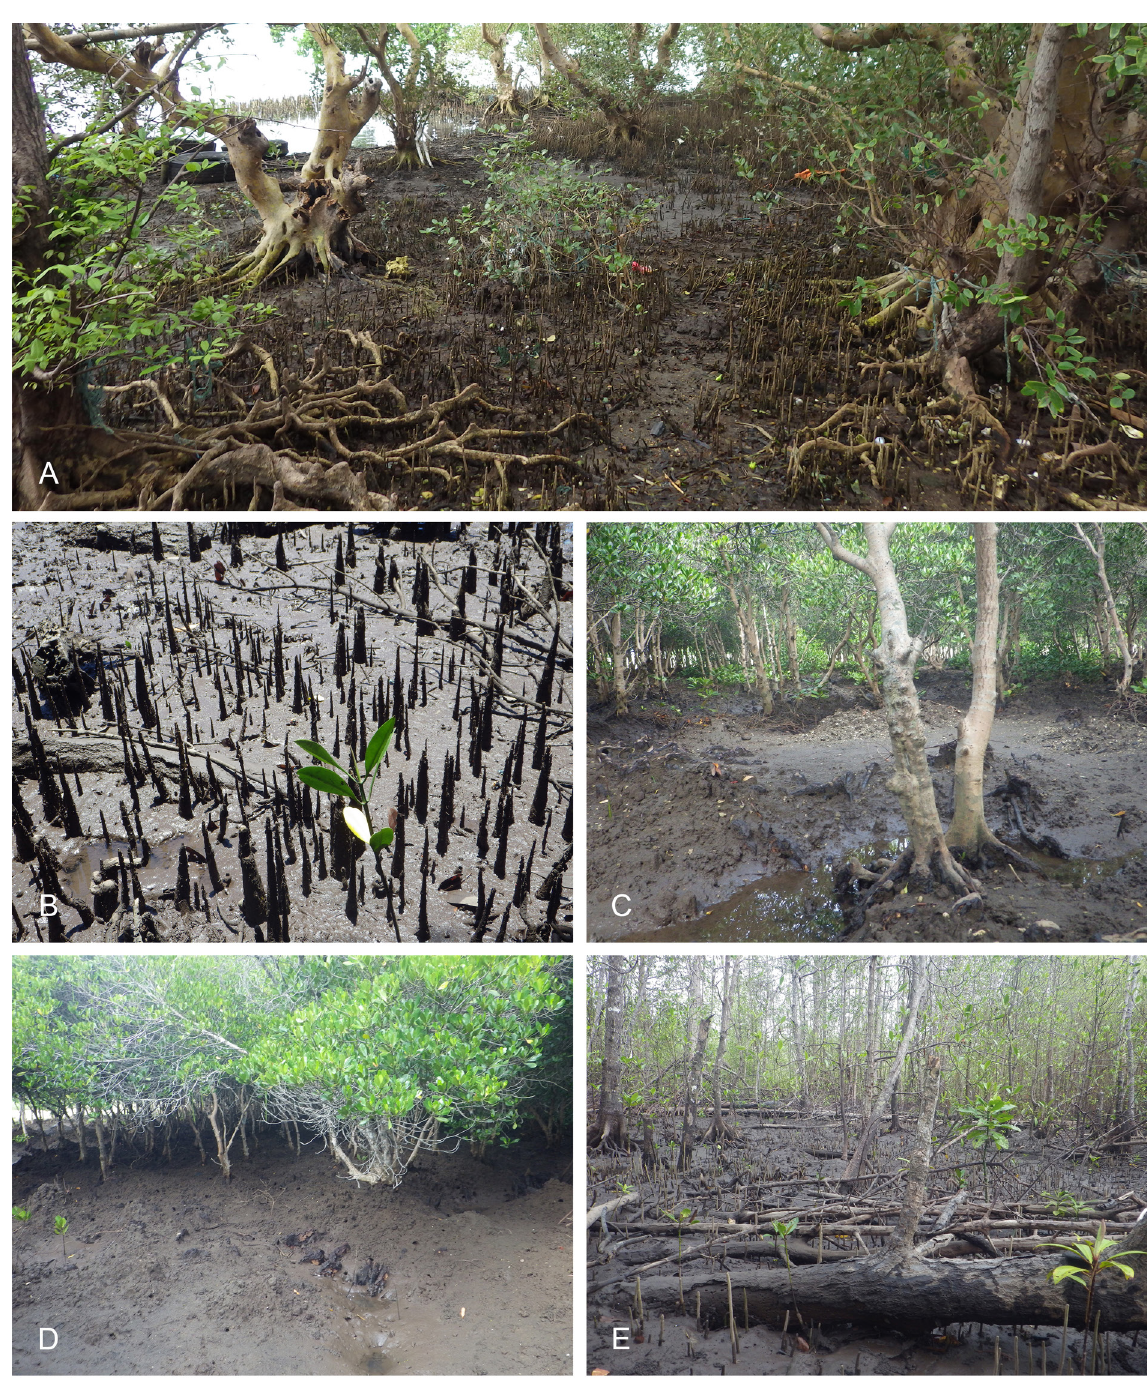
Fig. 51. Paromoionchis goslineri gen. et sp. nov., habitats. A . Philippines, Luzon, impacted mangrove next to a village, narrow band of Avicennia by the shore (station 185, type locality). B . Indonesia, Sulawesi, mostly Rhizophora , with sand, small rocks and pieces of wood outside narrow coastal mangrove (station 89). C . Indonesia, Bali, short mangrove shrubs, high intertidal, muddy area with pools (station 155). D . Indonesia, Bali, short mangrove shrubs high in intertidal, muddy area with pools (station 156). E . Indonesia, Halmahera, Rhizophora trees in open mangrove with sandy and muddy areas (station